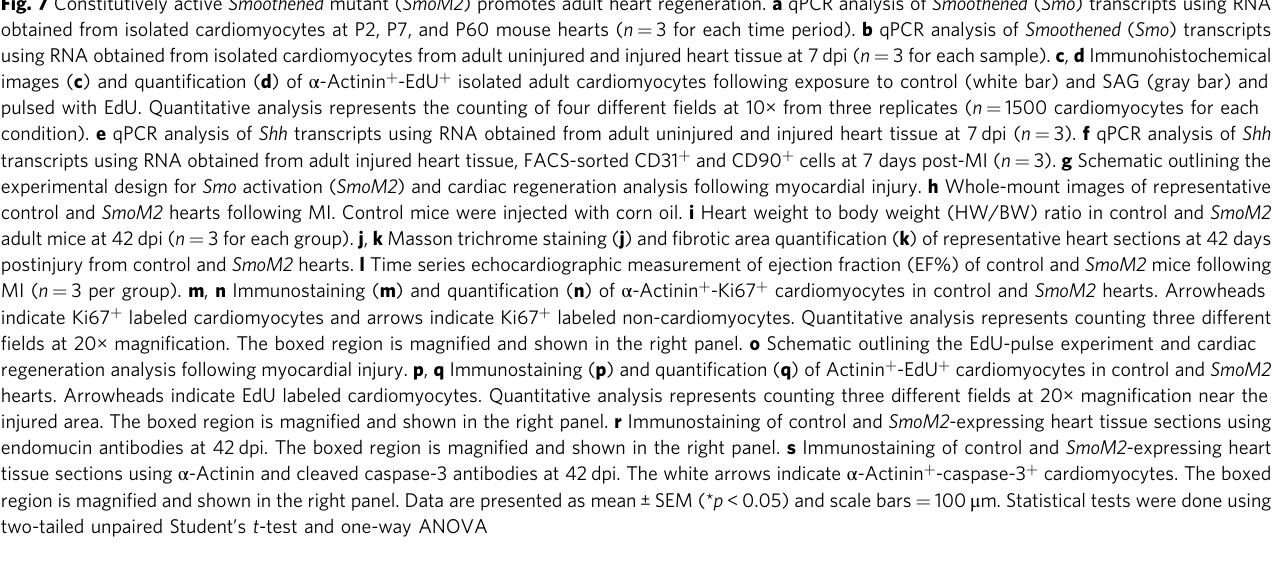
Fig. 7 Constitutively active Smoothened mutant ( SmoM2 ) promotes adult heart regeneration. a qPCR analysis of Smoothened ( Smo ) transcripts using RNA obtained from isolated cardiomyocytes at P2, P7, and P60 mouse hearts ( n = 3 for each time period). b qPCR analysis of Smoothened ( Smo ) transcripts using RNA obtained from isolated cardiomyocytes from adult uninjured and injured heart tissue at 7 dpi ( n = 3 for each sample). c , d Immunohistochemical images ( c ) and quanti fi cation ( d ) of α -Actinin + -EdU + isolated adult cardiomyocytes following exposure to control (white bar) and SAG (gray bar) and pulsed with EdU. Quantitative analysis represents the counting of four different fi elds at 10× from three replicates ( n = 1500 cardiomyocytes for each condition). e qPCR analysis of Shh transcripts using RNA obtained from adult uninjured and injured heart tissue at 7 dpi ( n = 3). f qPCR analysis of Shh transcripts using RNA obtained from adult injured heart tissue, FACS-sorted CD31 + and CD90 + cells at 7 days post-MI ( n = 3). g Schematic outlining the experimental design for Smo activation ( SmoM2 ) and cardiac regeneration analysis following myocardial injury. h Whole-mount images of representative control and SmoM2 hearts following MI. Control mice were injected with corn oil. i Heart weight to body weight (HW/BW) ratio in control and SmoM2 adult mice at 42 dpi ( n = 3 for each group). j , k Masson trichrome staining ( j ) and fi brotic area quanti fi cation ( k ) of representative heart sections at 42 days postinjury from control and SmoM2 hearts. l Time series echocardiographic measurement of ejection fraction (EF%) of control and SmoM2 mice following MI ( n = 3 per group). m , n Immunostaining ( m ) and quanti fi cation ( n ) of α -Actinin + -Ki67 + cardiomyocytes in control and SmoM2 hearts. Arrowheads indicate Ki67 + labeled cardiomyocytes and arrows indicate Ki67 + labeled non-cardiomyocytes. Quantitative analysis represents counting three different fi elds at 20× magni fi cation. The boxed region is magni fi ed and shown in the right panel. o Schematic outlining the EdU-pulse experiment and cardiac regeneration analysis following myocardial injury. p , q Immunostaining ( p ) and quanti fi cation ( q ) of Actinin + -EdU + cardiomyocytes in control and SmoM2 hearts. Arrowheads indicate EdU labeled cardiomyocytes. Quantitative analysis represents counting three different fi elds at 20× magni fi cation near the injured area. The boxed region is magni fi ed and shown in the right panel. r Immunostaining of control and SmoM2 -expressing heart tissue sections using endomucin antibodies at 42 dpi. The boxed region is magni fi ed and shown in the right panel. s Immunostaining of control and SmoM2 -expressing heart tissue sections using α -Actinin and cleaved caspase-3 antibodies at 42 dpi. The white arrows indicate α -Actinin + -caspase-3 + cardiomyocytes. The boxed region is magni fi ed and shown in the right panel. Data are presented as mean ± SEM (* p < 0.05) and scale bars = 100 μ m. Statistical tests were done using two-tailed unpaired Student ’ s t -test and one-way